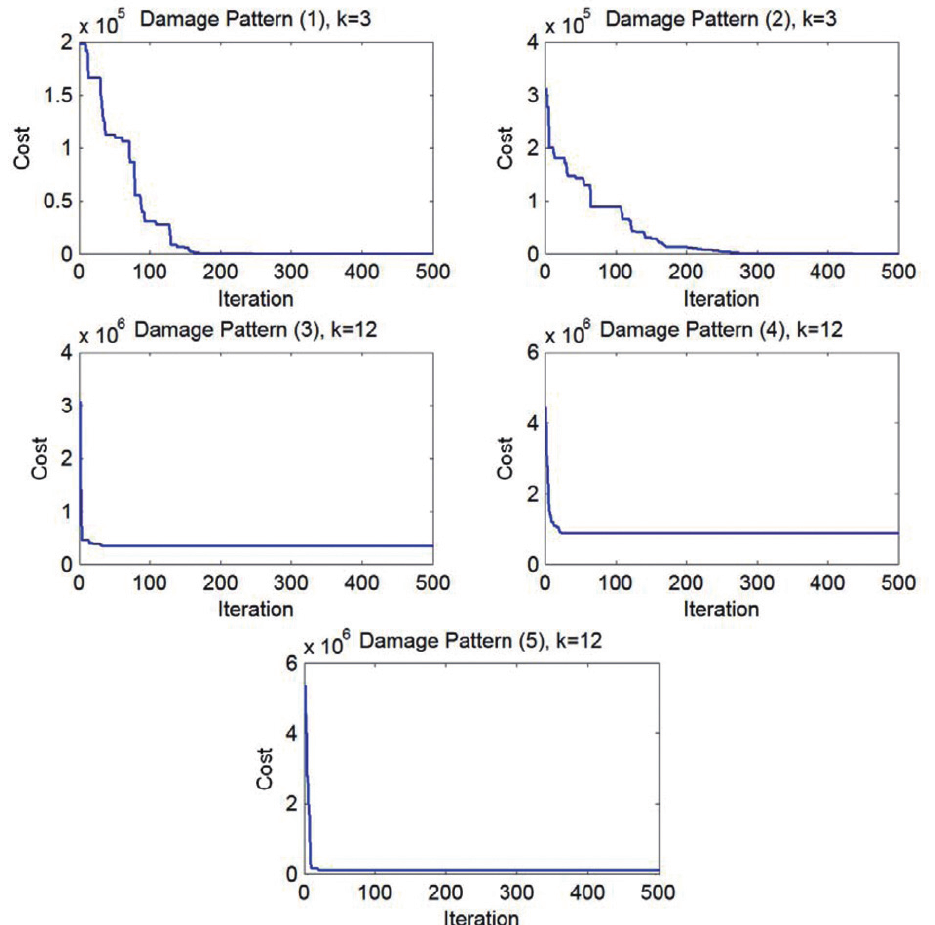
Fig. 4. Convergence curves for fi ve damage patterns of the benchmark